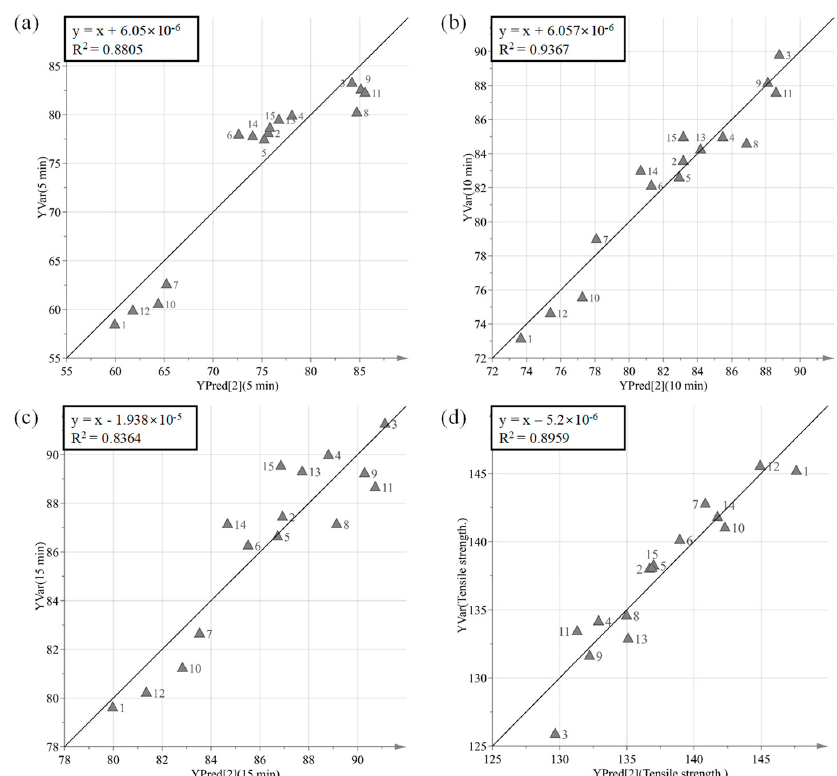
Figure 8. Predicted versus measured plots for tensile strengths (CQAs). (a) % dissolution at 5 min, (b) % dissolution at 10 min, (c) % dissolution at 15 min, and (d) tensile strength.